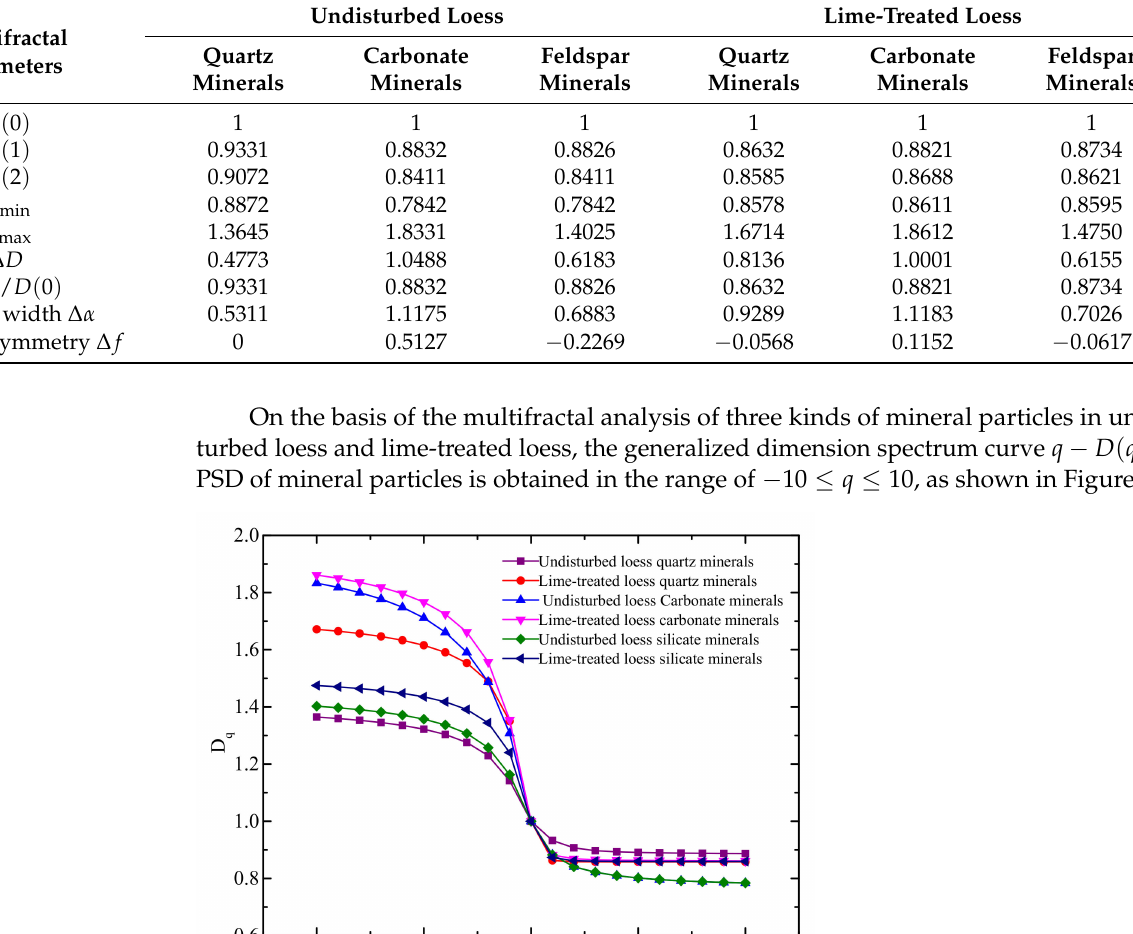
Table 1. Multifractal parameters of different mineral particles in undisturbed loess and lime-treated loess. Multifractal